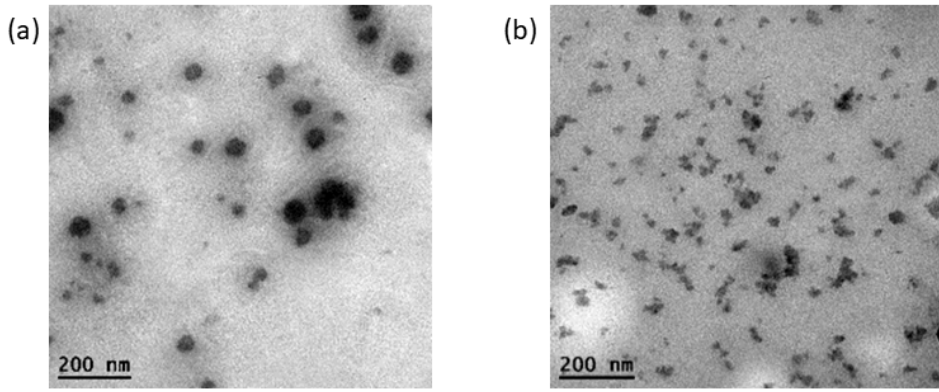
Figure 8. TEM images obtained for the GQD_125 ( a ) and GQD_175 ( b ) samples.